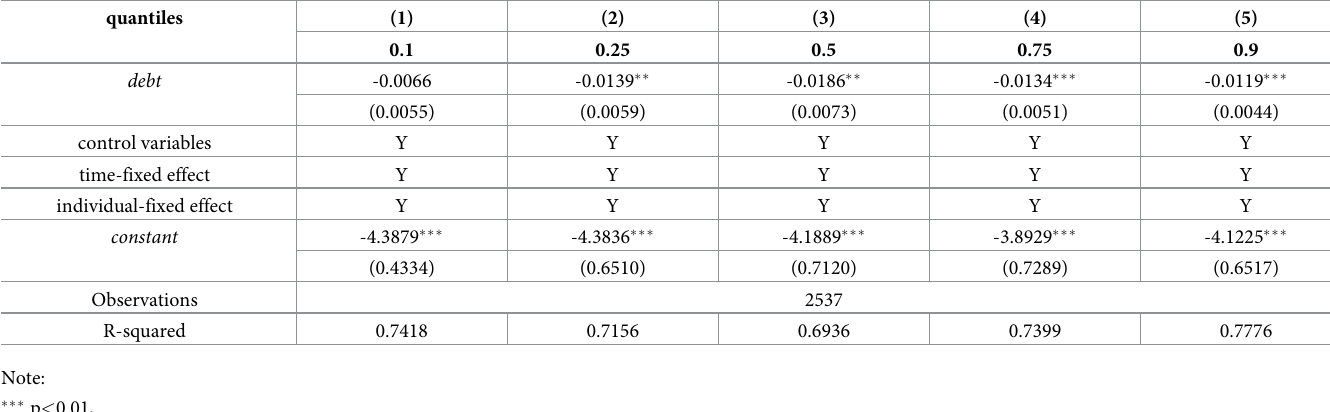
Table 4. Quantile regression